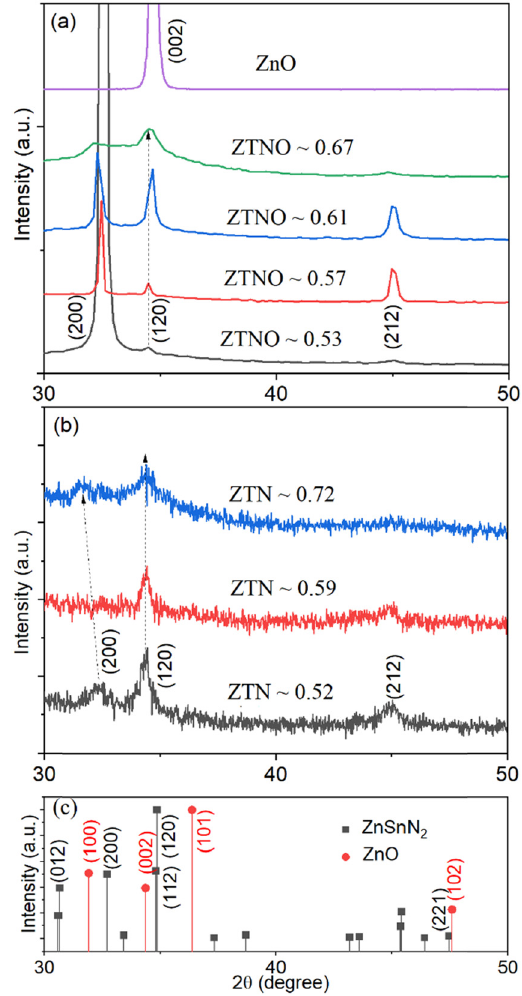
Figure 5: ( a ) X - ray di ff raction patterns of ZTNO thin fi lms on glass substrates with various Zn/ ( Zn + Sn ) ( 0.53, 0.57, 0.61 and 0.65 ) compositions grown by a sputtering chamber with the background vacuum of 10 − 3 Pa. ZnO thin fi lm grown by the same chamber is plotted for comparison. ( b ) X - ray di ff raction patterns of ZTN thin fi lms with various Zn/ ( Zn + Sn ) ( 0.52, 0.59 and 0.72 ) compositions grown by a sputtering chamber with the background vacuum of 10 − 7 Pa. ( c ) Theoretical di ff raction patterns of ZnSnN 2 and ZnO ( authors ’ original work )